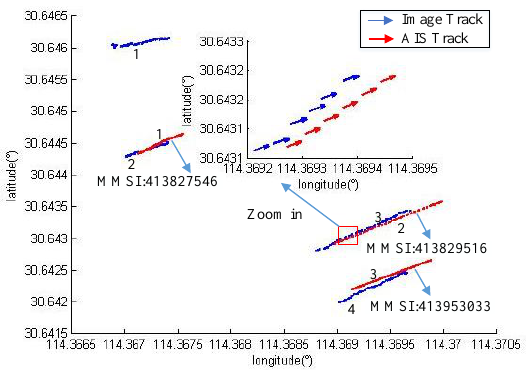
Figure 17. The identification results for four